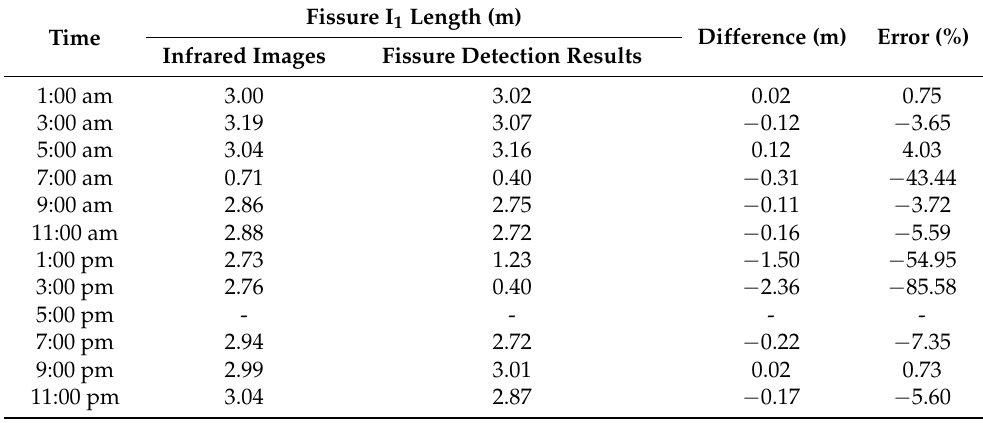
Table 5. The Fissure I 1 length in infrared images and that in fissure detection